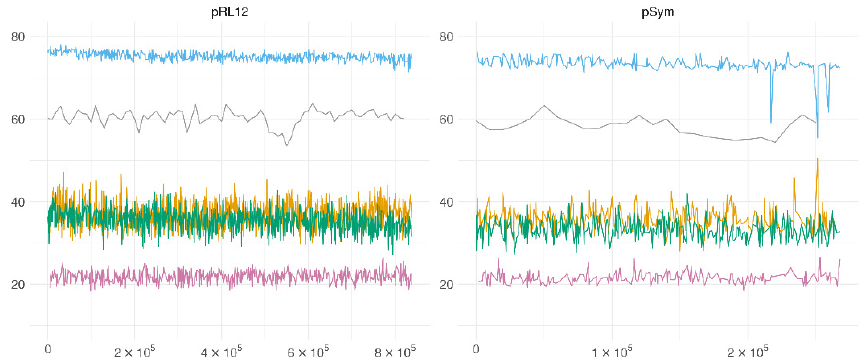
Figure 2. DNA methylation patterns. The plots represent the percentage of methylated adenine or cytosine in the R. leguminosarum RCAM1026 genome shown across a 5 kb sliding window. The y scale shows the percentage of methylated reads mapped to the position. Blue—mA in bacteroids, purple—mA in cell culture, yellow—mC in bacteroids, green—mC in cell culture, grey—GC content.